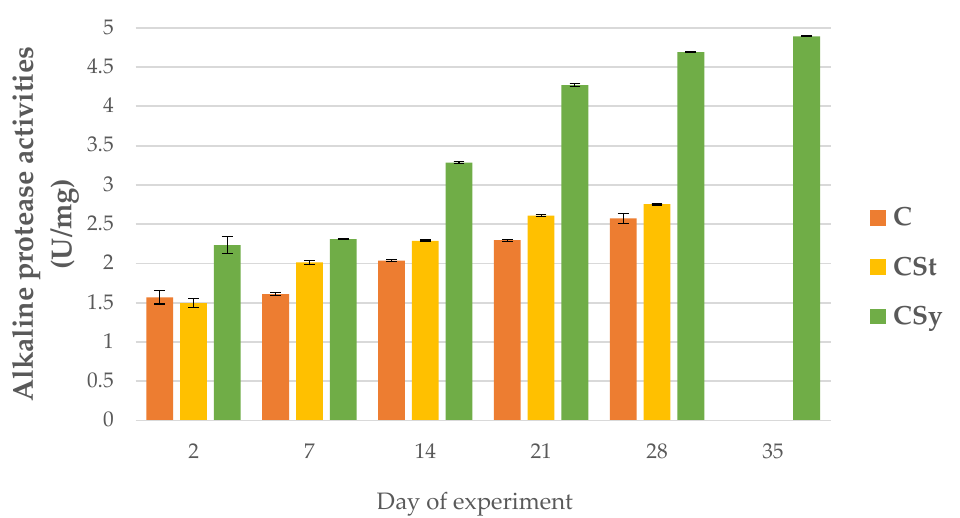
Figure 4. Alkaline protease activities in the 2, 7, 14, 21, 28, 35-day-old honey bees’ hemolymph after two methods of supplementation with hemp extract: C-control (pure sugar syrup), CSy-hemp extract in syrup, CSt-hemp extract on strips; two-Way ANOVA: supplementation method: F (2, 156) = 75.790, p = 0.0000, se ± 0.105637 – 0.096433; days of supplementation: F (4, 143) = 7364.6, p = 0.0000, se ± 0.007821 – 0.013546; supplementation method × days of supplementation F (8, 143) = 856.83, p = 0.00094, se ± 0.013546.